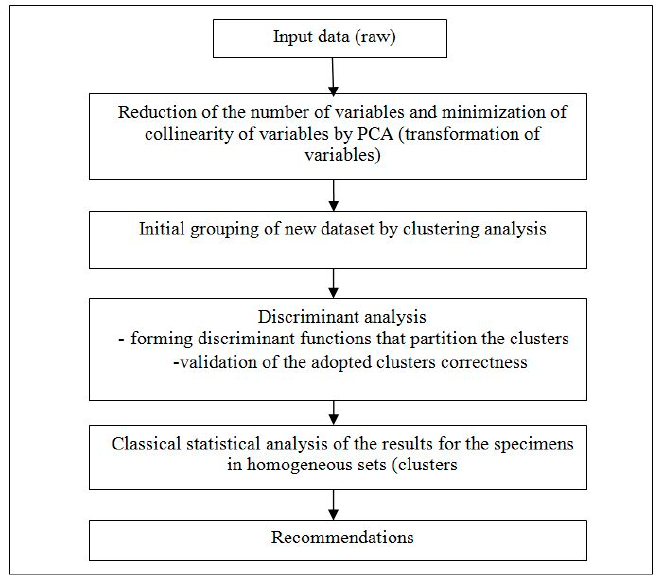
Figure 2. Multidimensional analysis stages.